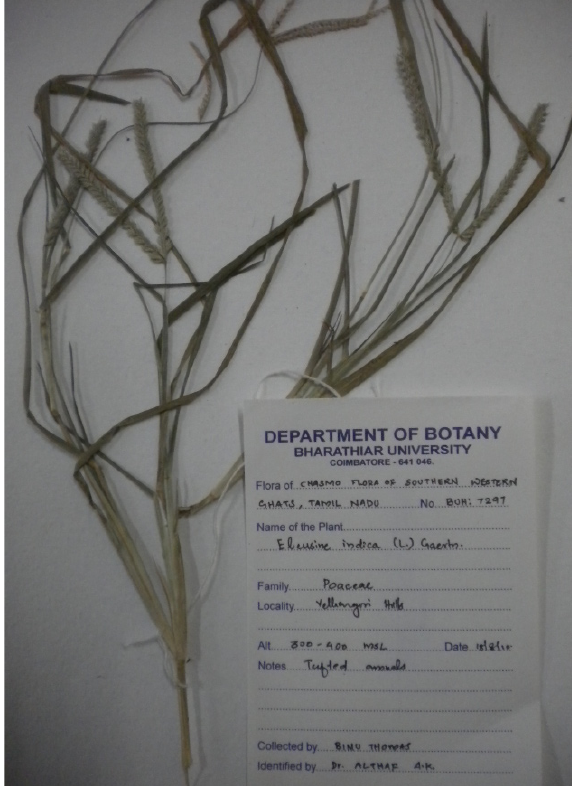
Image 17. Eragrostis aspera (Jacq.) Nees